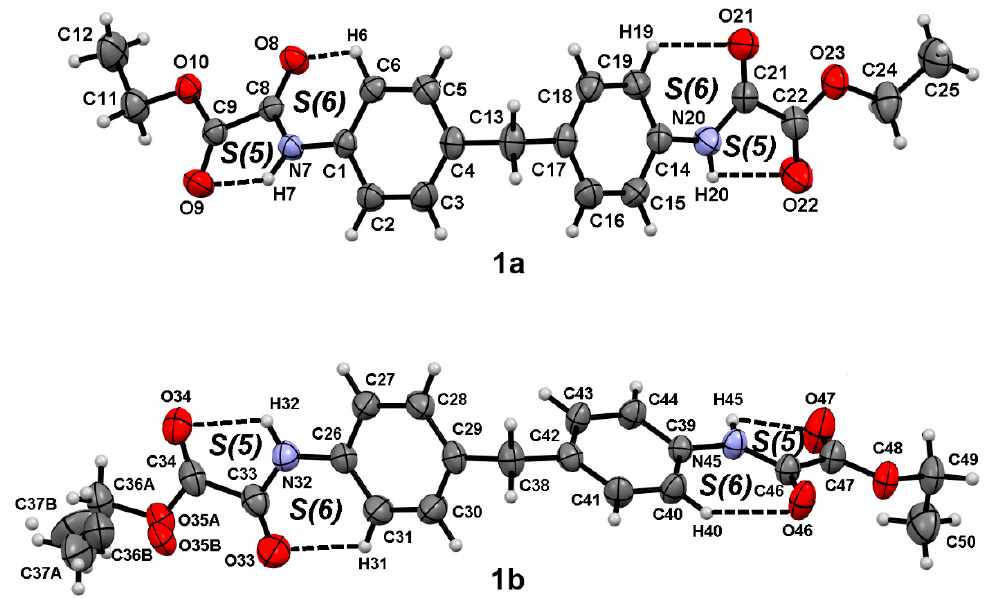
Figure 3. Molecular structure of 1a and 1b at 30% of probability level showing the atom numbering scheme and the intramolecular interactions.